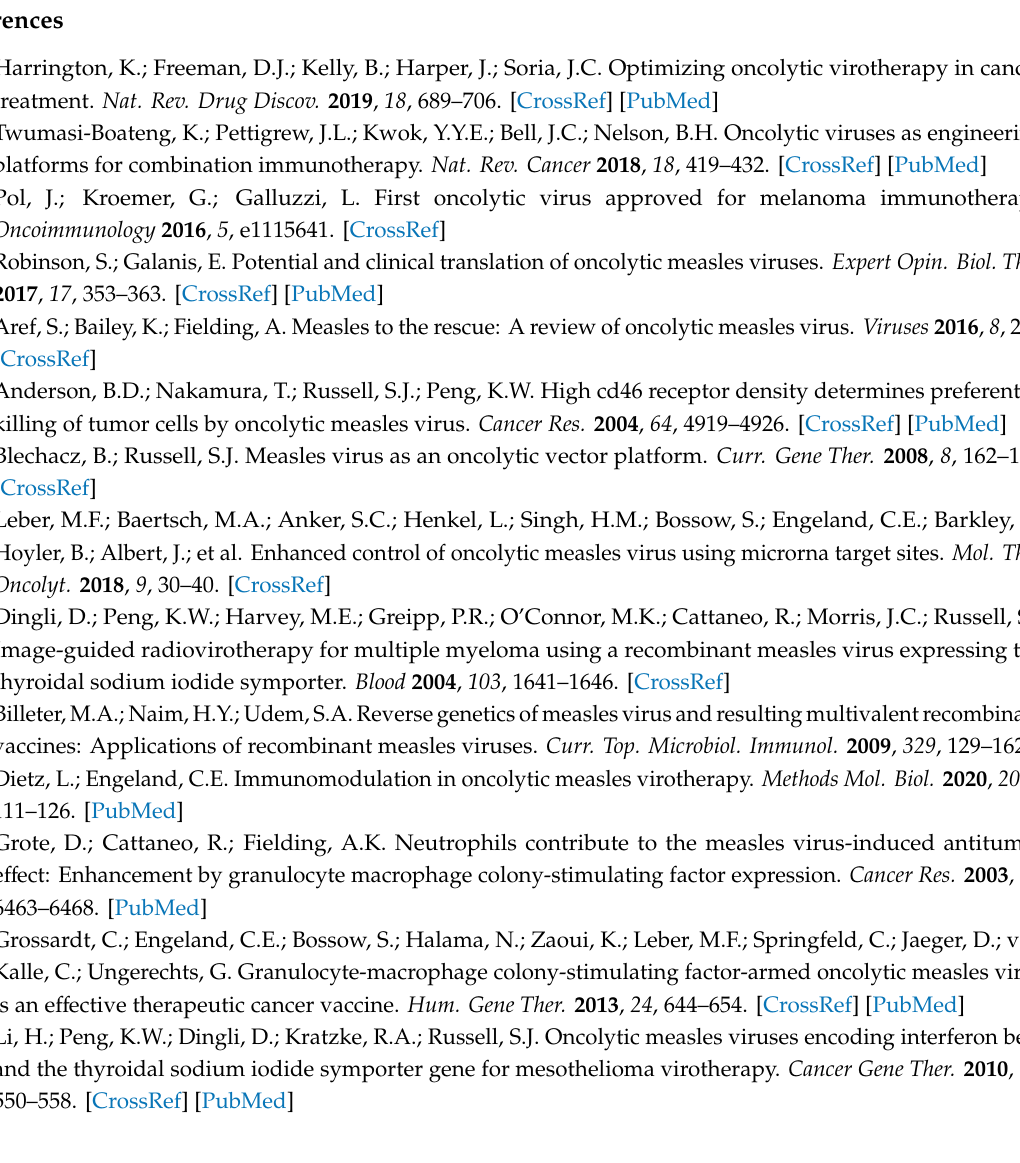
Figure S6: Human colorectal cancer cells are susceptible to oncolytic measles virus. Supplementary Table S1: Histopathological analyses of MC38cea tumor samples. Supplementary files: Raw data of NanoString